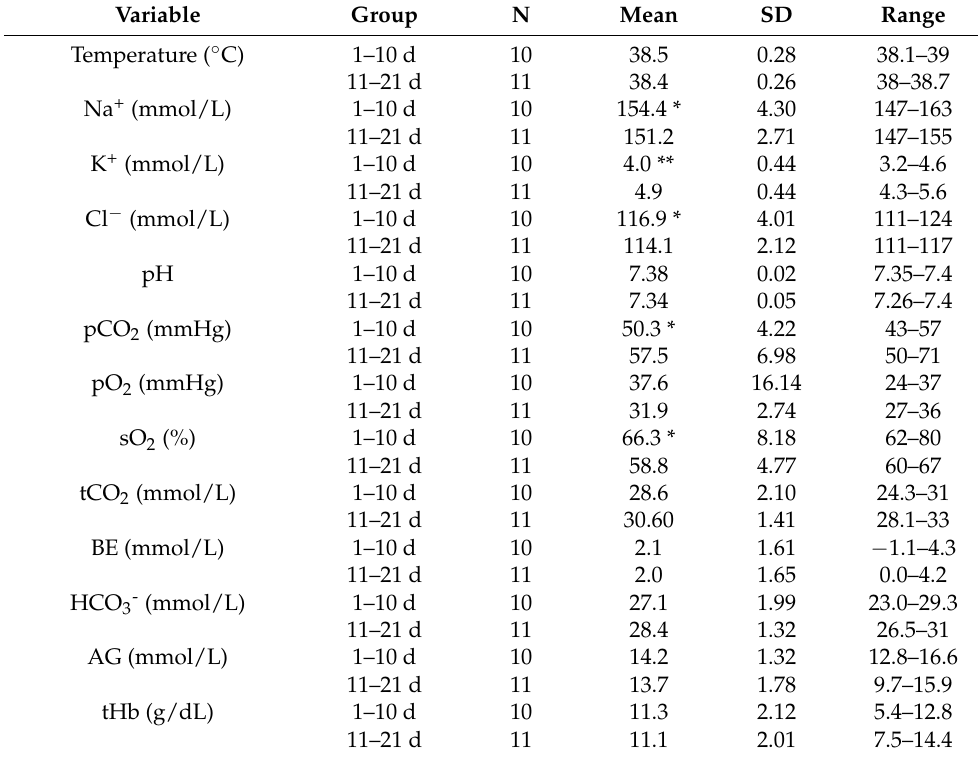
Table 1. Mean ( ± SD) data and min-max ranges for each venous blood gas analysis variable in the two age-groups of clinically healthy dromedary